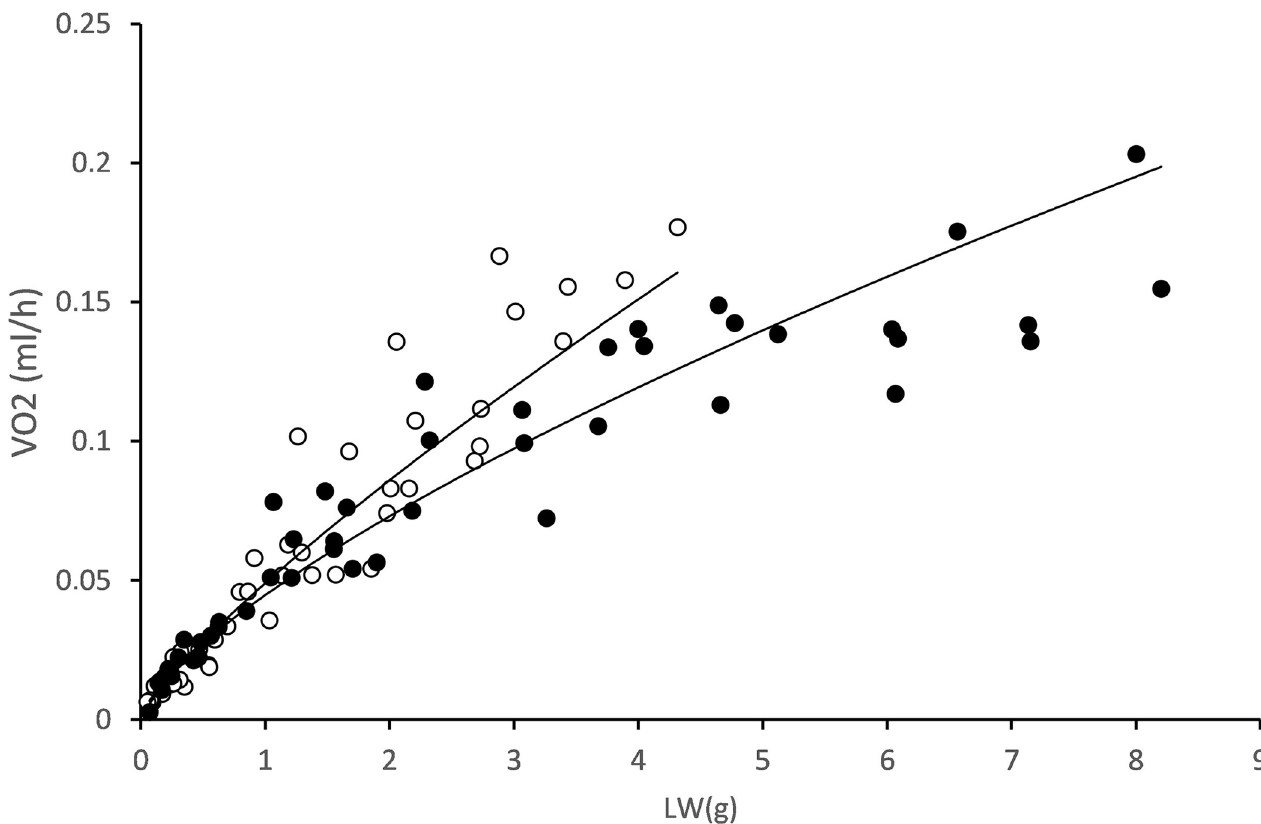
Fig 7. Regression lines for the allometric relationships of the form SMR = a � LW b for mussels from Group 2 after 2 wk. ( Intraspecific 1 : upper line; hollow symbols) and 4 mo. ( Intra-specific2 : lower line; full symbols) maintenance in laboratory conditions.